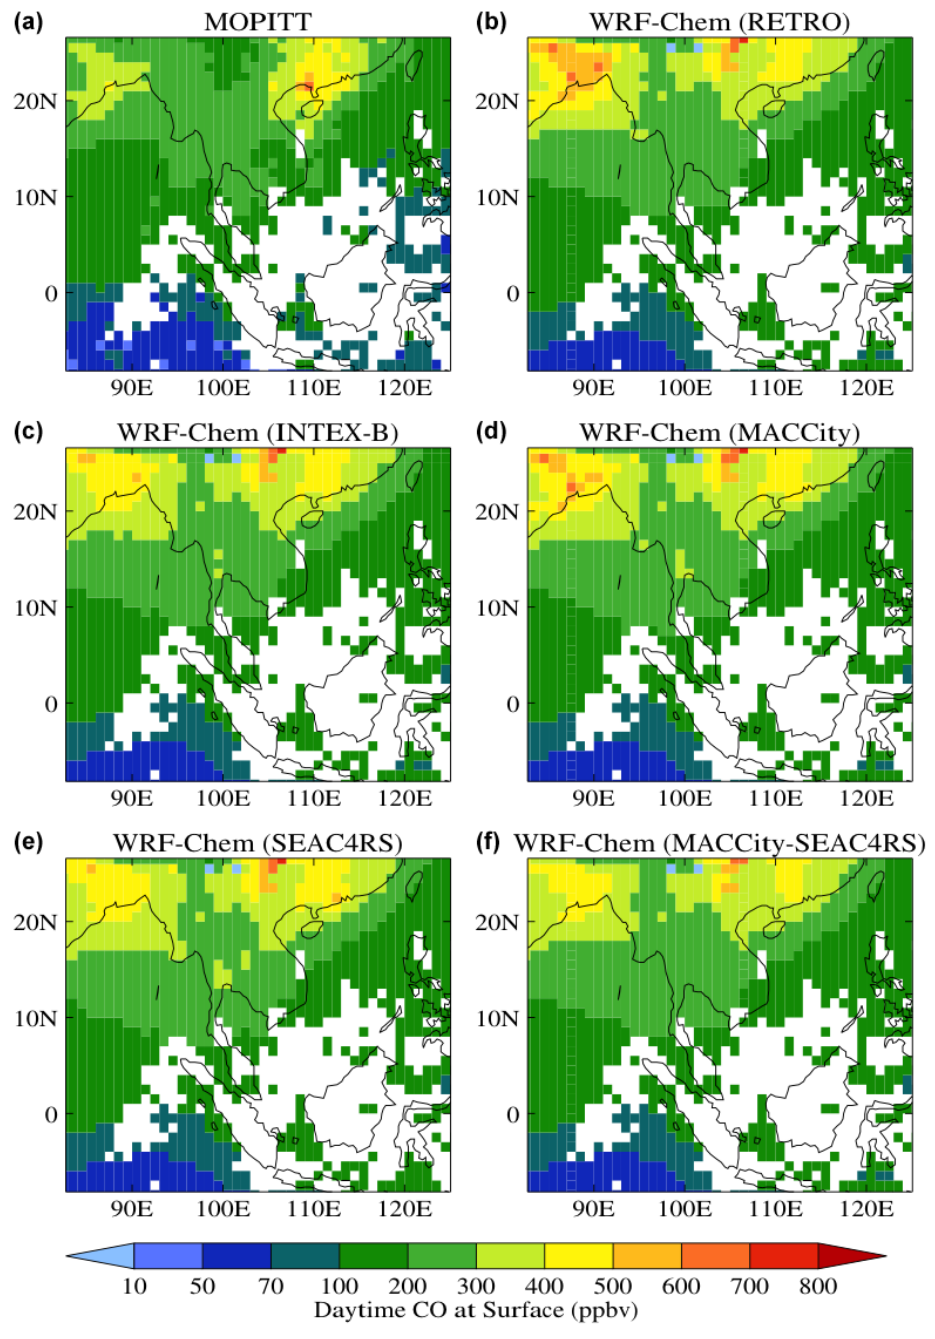
Figure 11. Same as Fig. 10 but for